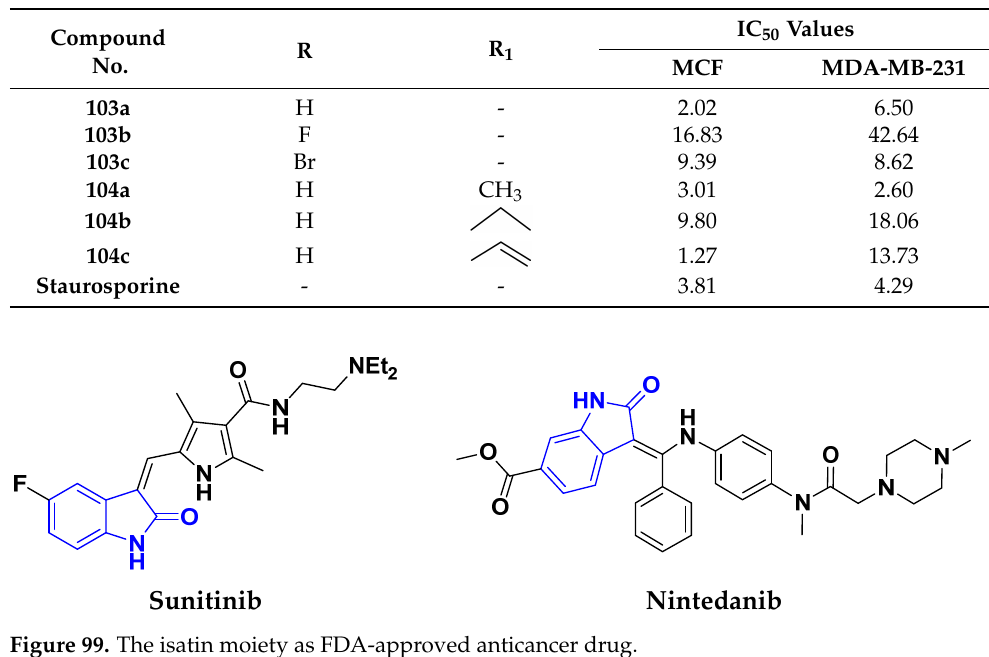
Table 88. In vitro cytotoxic activities of isatin-thiazolo benzimidazole hybrid compounds 103 ( a – c ) and, 104 ( a – c ).